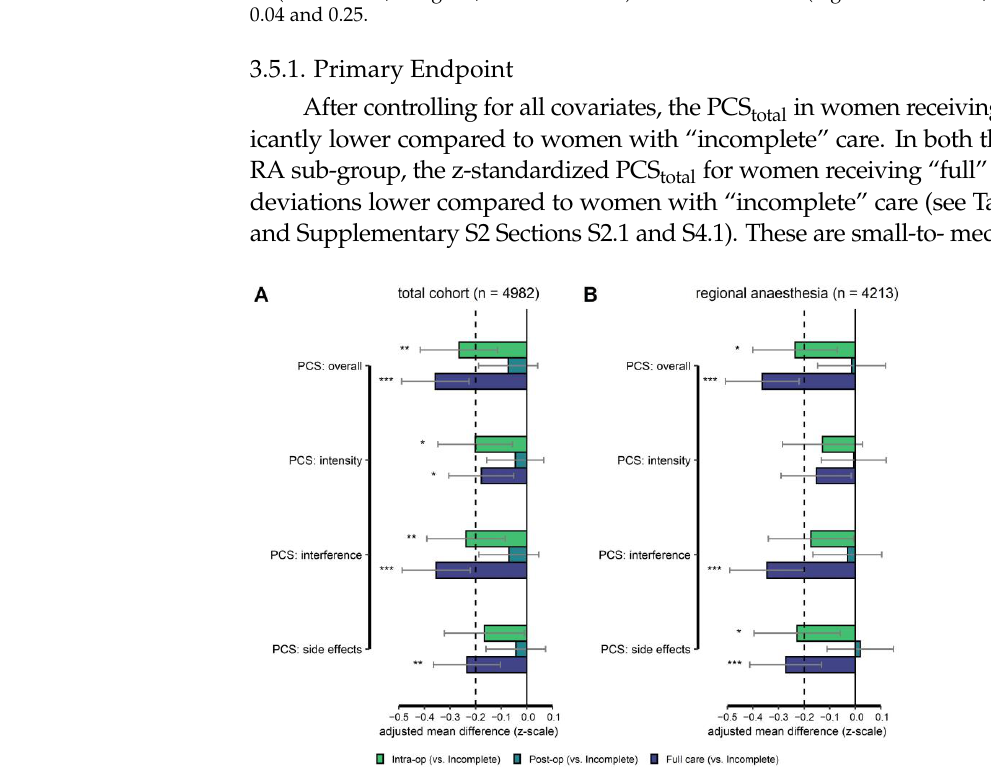
Figure 3. Results of the regression analyses. Regression weights (differences in covariate adjusted means), with 95% confidence intervals for each care group The “incomplete” group served as a reference. Significant differences between the “incomplete” group and other groups (intra-operative [green bars], post-operative [petrol bars], and full care [purple bars]) are marked with asterisks. All p -values were corrected using the Bonferroni-Holm procedure. The Pain Composite Score (and sub- scores) were z-standardized before modeling. Thus, mean differences can be interpreted in terms of standard deviations (absolute values ≥ 0.2 for small effect sizes , ≥ 0.5 for medium effect sizes, and ≥ 0.8 for large effect size). The broken vertical line at − 0.2 level on the x-axis marks the level of a small effect size. Negative values indicate “better” outcomes compared to the “ i ncomplete” group. Results for the total cohort are shown in ( A ) and results for women receiving only regional anesthesia in ( B ). * p <0.05, ** p <0.01, *** p <0.001